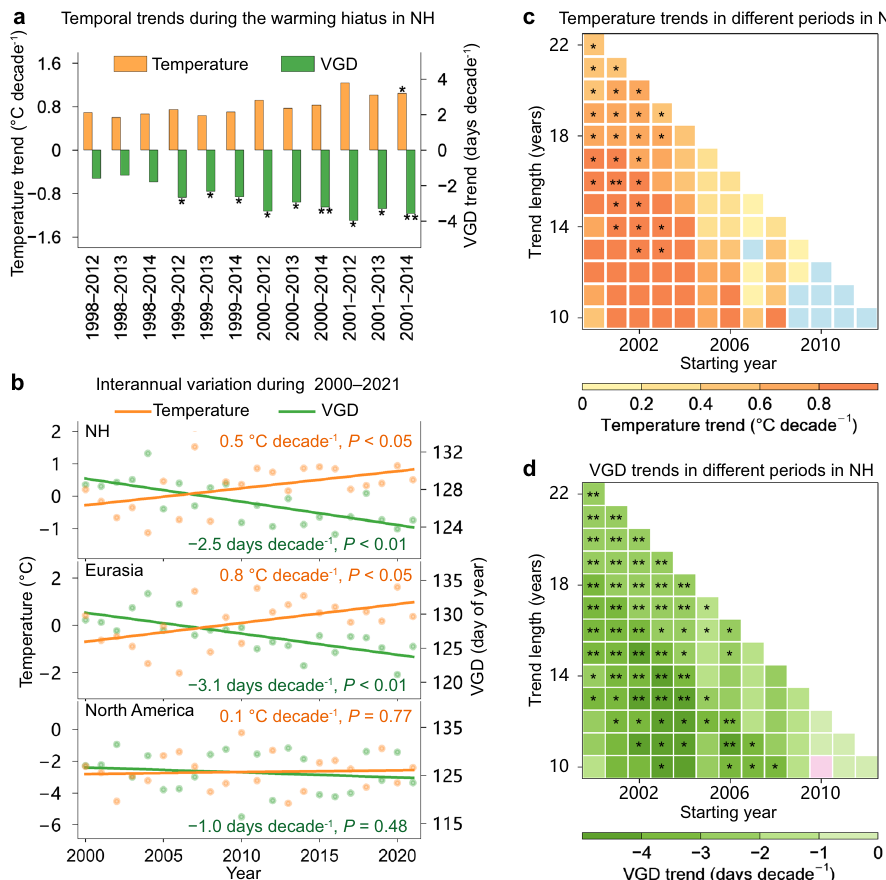
Fig. 1 Temporal trend in onset date of vegetation green-up (VGD) and mean temperature in the period preceding VGD (pre-VGD temperature) at hemisphere and continental scales. Temporal trends in pre-VGD temperature and VGD averaged over the mid- and upper- latitudes (30 – 75°N) of the Northern Hemisphere (NH) during the warming hiatuses reported in previous studies ( a ), over the NH, Eurasia, and North America, respectively, during 2000 – 2021 ( b ), and over the NH during the periods of different lengths starting between 2000 and 2012 ( c , d ). Positive and negative trends in VGD indicate delay and advance, respectively. * P < 0.05 and ** P < 0.01. VGD is determined by the threshold-based method (see Supplementary Methods) as the fi rst date when NDVI increases by 20% of the annual amplitude in the ascending period of the annual NDVI trajectory. VGD was derived from MODIS NDVI since 2000 and from AHVRR NDVI3g.v1 in 1998 and 1999 (see Supplementary